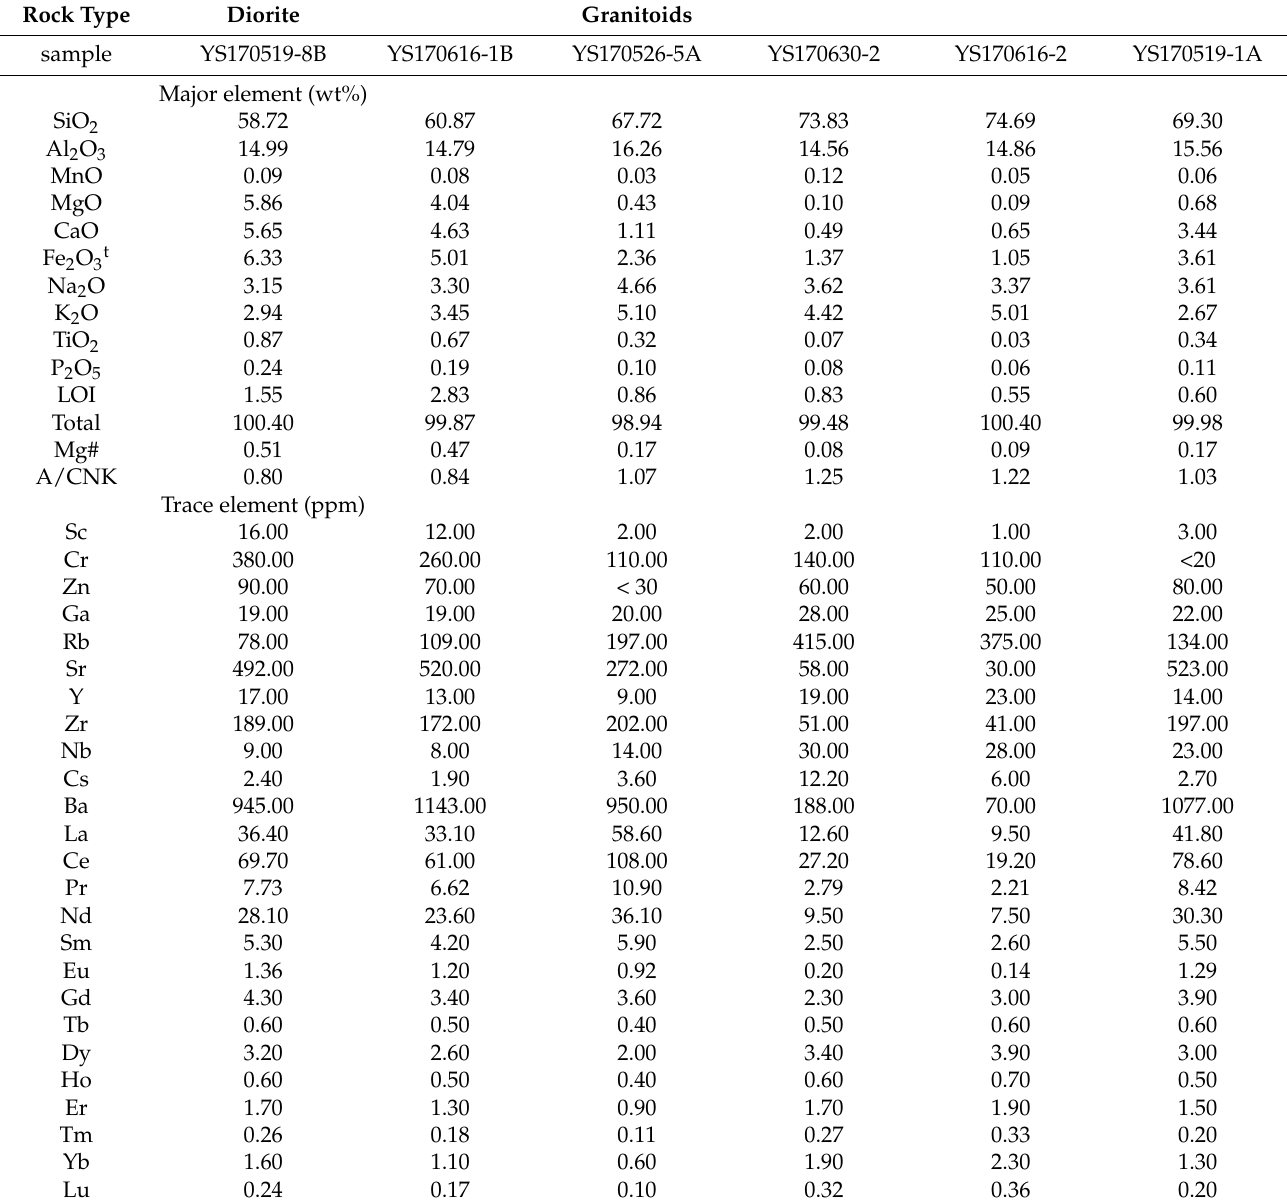
Table 1. Whole-rock composition of the Jurassic diorite and granite in the Yuseong